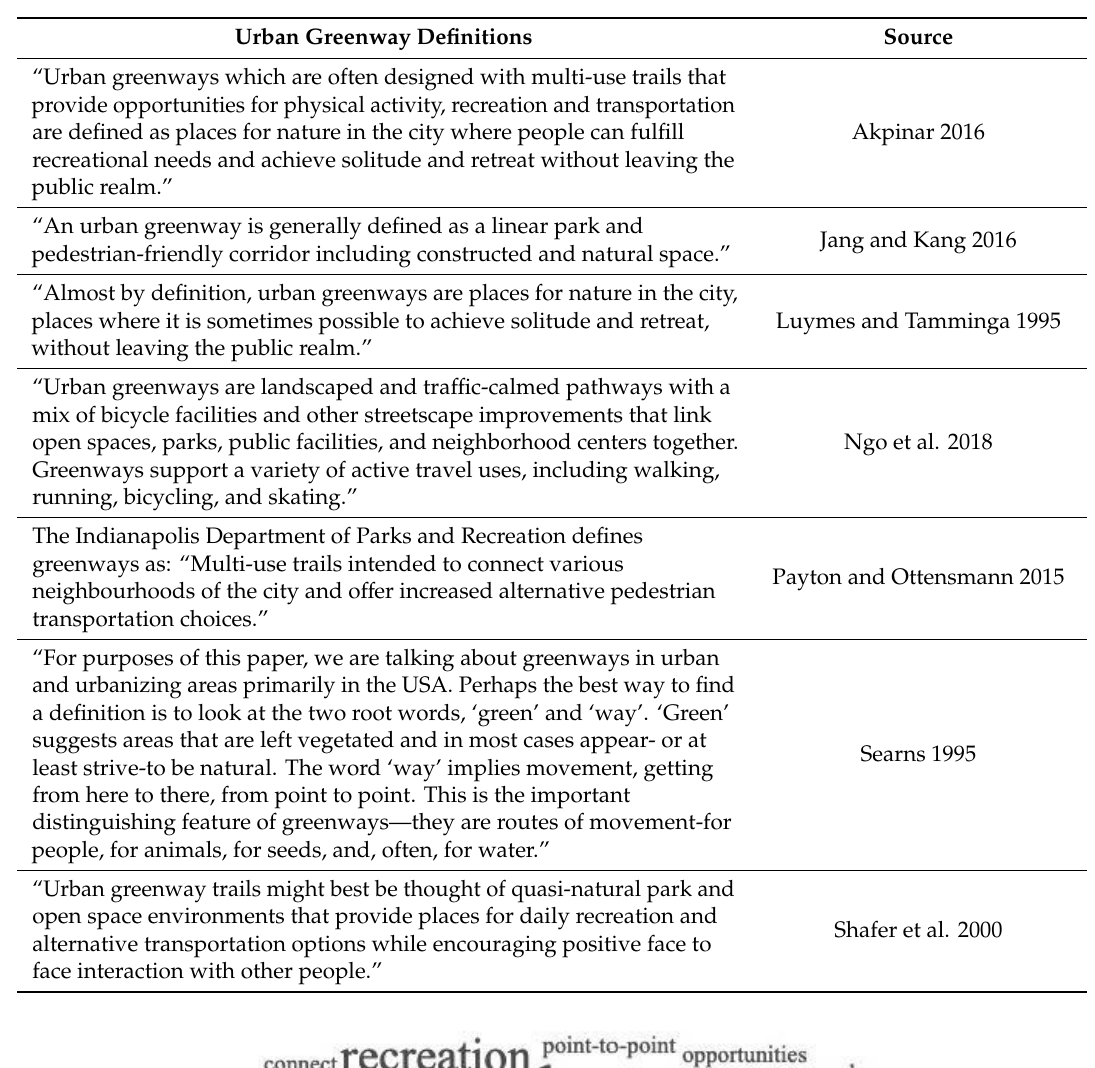
Table 5. Definitions of urban greenways.